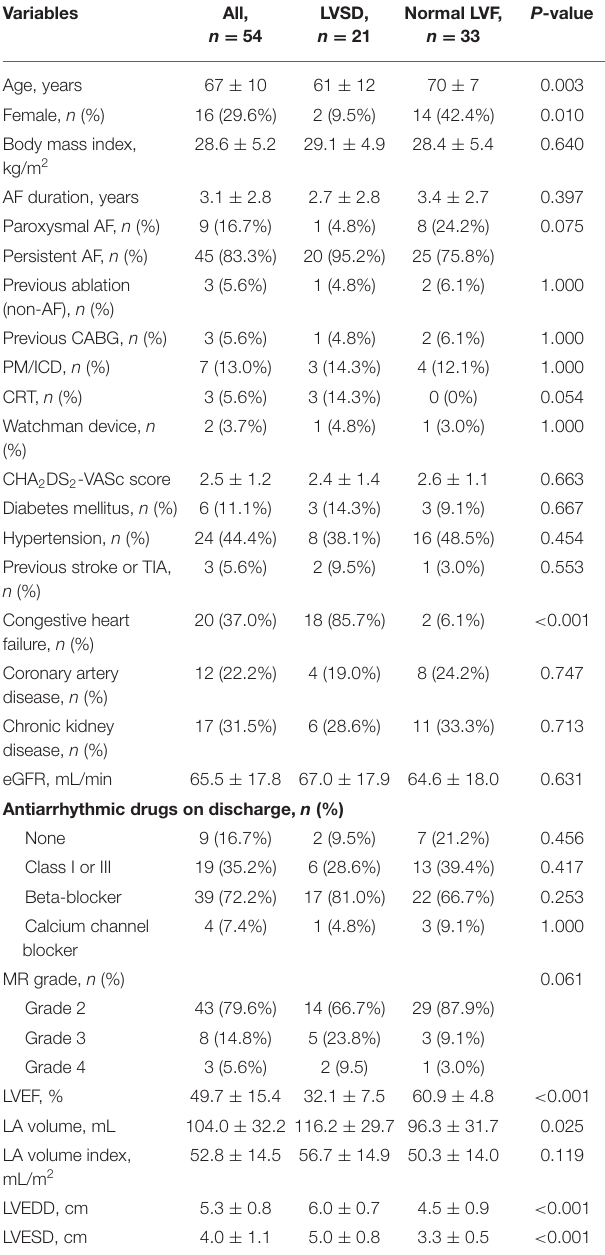
LVSD,leftventricularsystolicdysfunction;LVF,leftventricularfunction;AF,atrialfibrillation; CABG, coronary artery bypass grafting; PM, pacemaker; ICD, implantable cardioverter- defibrillator; CRT, cardiac resynchronization therapy; eGFR, estimated glomerular filtration rate; MR, mitral regurgitation; LVEF, left ventricular ejection fraction; LA, left atrial; LVEDD, left ventricular end-diastolic dimensions; LVESD, left ventricular end-systolic dimensions.